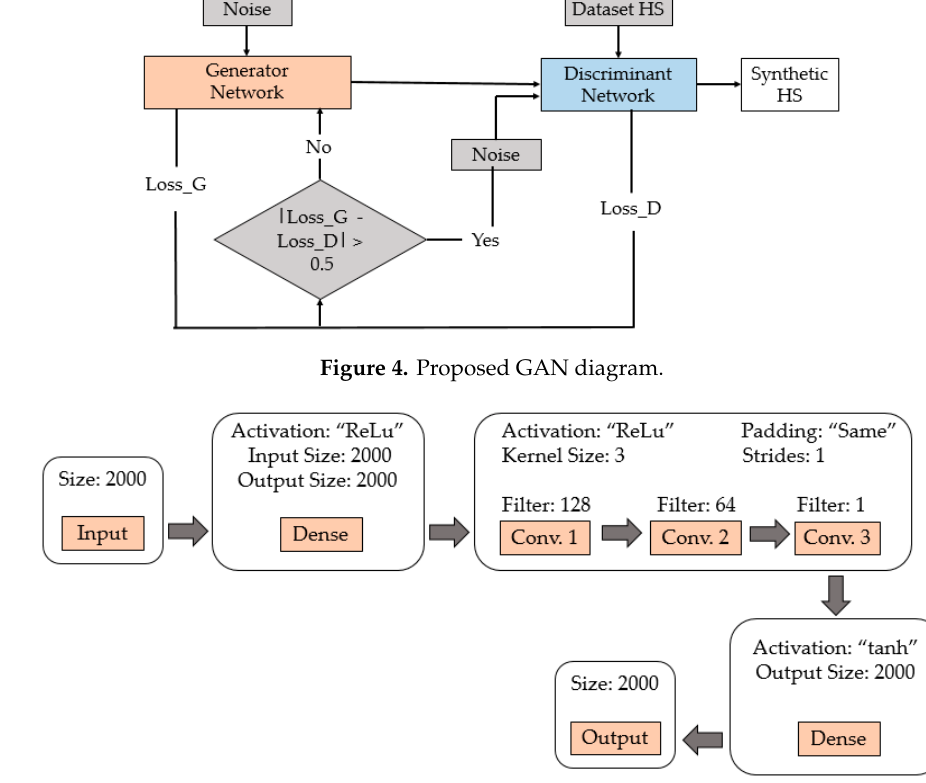
Figure 6. Architecture of the discriminator model. Taking into account that the input of the GAN model is a Gaussian noise, and in turn, the output of the model during the first epochs of training is expected to be a signal mixed with Gaussian noise, it was decided to do a test using a real heart signal mixed with Gaussian noise to evaluate the performance of the proposed EWT filter on signals with the same expected characteristics of the generator’s output. Figure 7A,B shows, respectively, a real heart sound and the same heart sound mixed with low-amplitude Gaussian noise, while Figure 7C,D shows their respective Fourier transforms (FFTs). In this last figure, the frequency of the components between 0 and 200 Hz can be seen in blue, and the frequency of components above 200 Hz caused by the Gaussian noise are in green. The signal shown in Figure 7B was then used as an input example to the proposed EWT algorithm to illustrate its de-noising action. Figure 7D shows the two frequency bands extracted with EWT using the FFT, while Figure 7E,F shows the two components extracted from the noisy signal in the time domain. As can be seen, the signal obtained in Figure 7E presents a lower noise level, and is comparable with the original cardiac signal shown in Figure 7A.